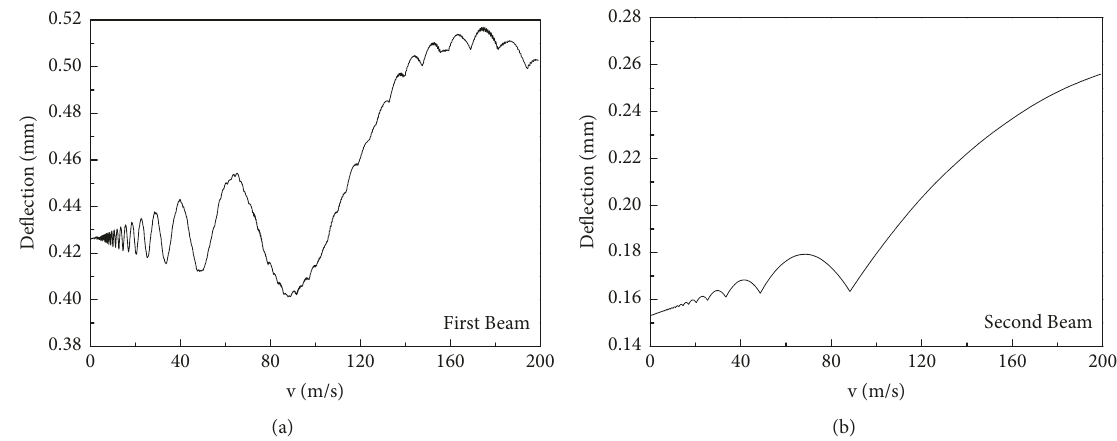
Figure 8: Relationship between maximum deflection and loading speed for mid-span of double simply supported beam with first beam’s moment of inertia taking as 100I 1 : (a) first beam; (b) second beam.